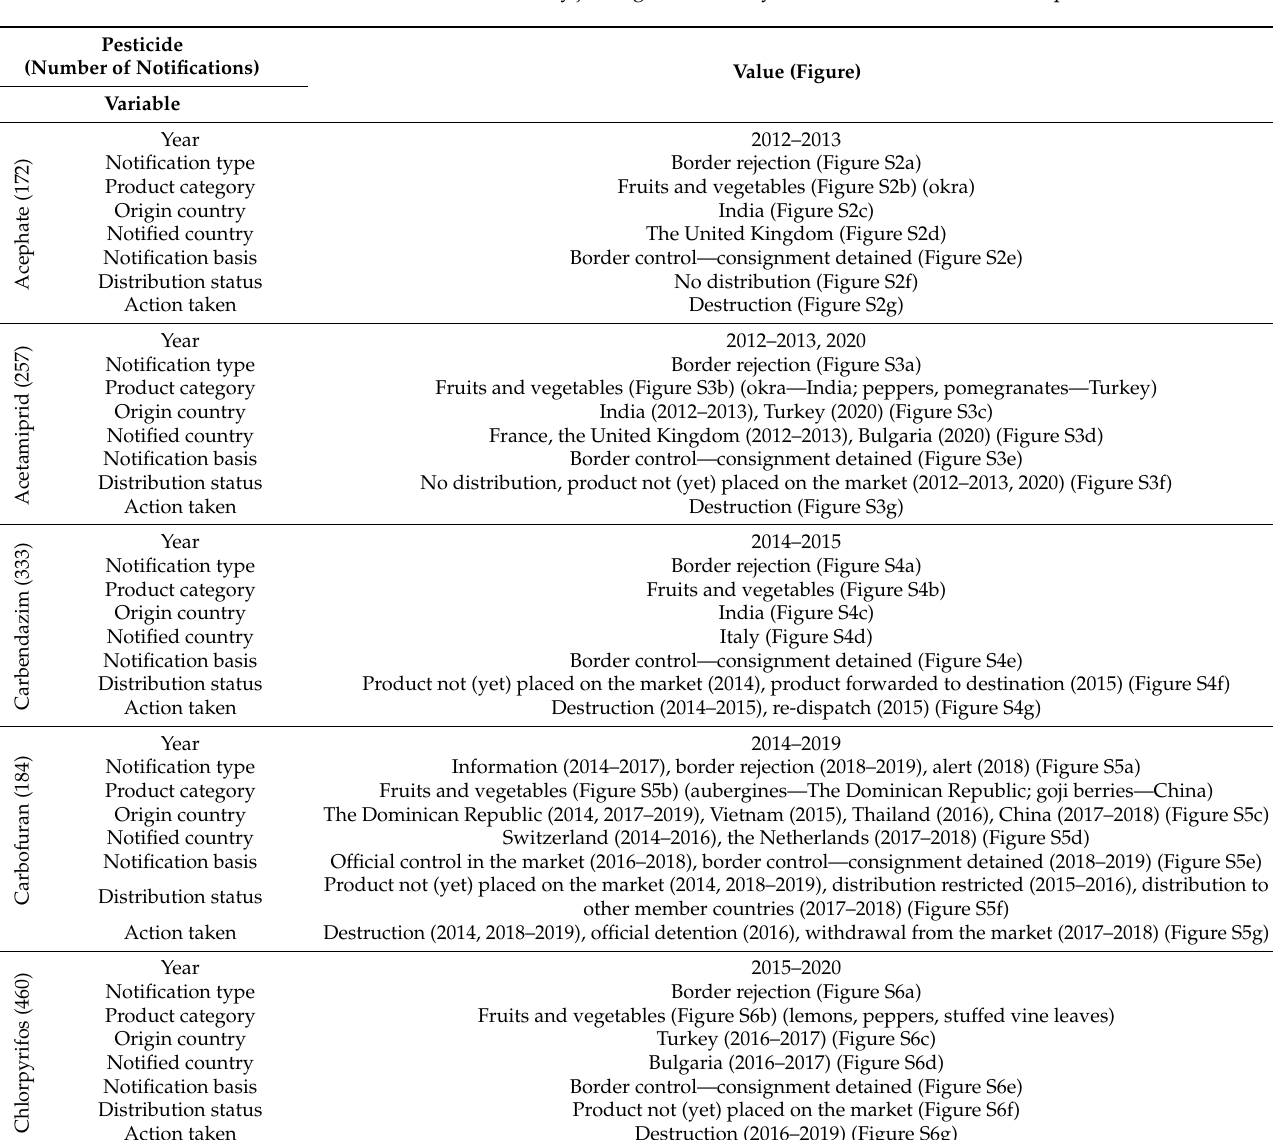
Table 3. Results of two-way joining cluster analysis related to notifications on pesticides in the